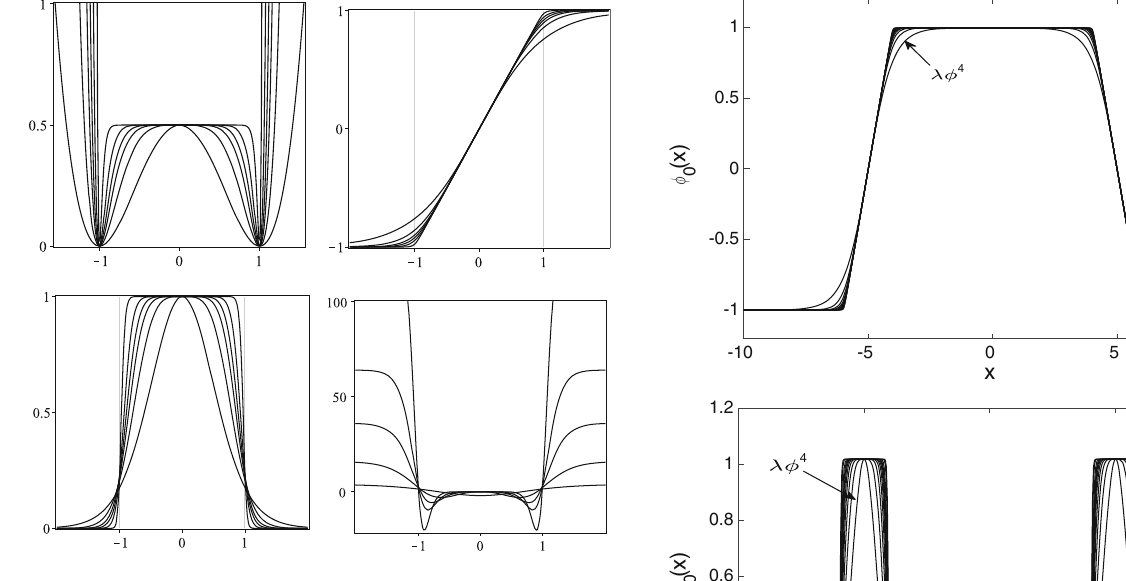
with speed u in the positive x direction if u > 0. For